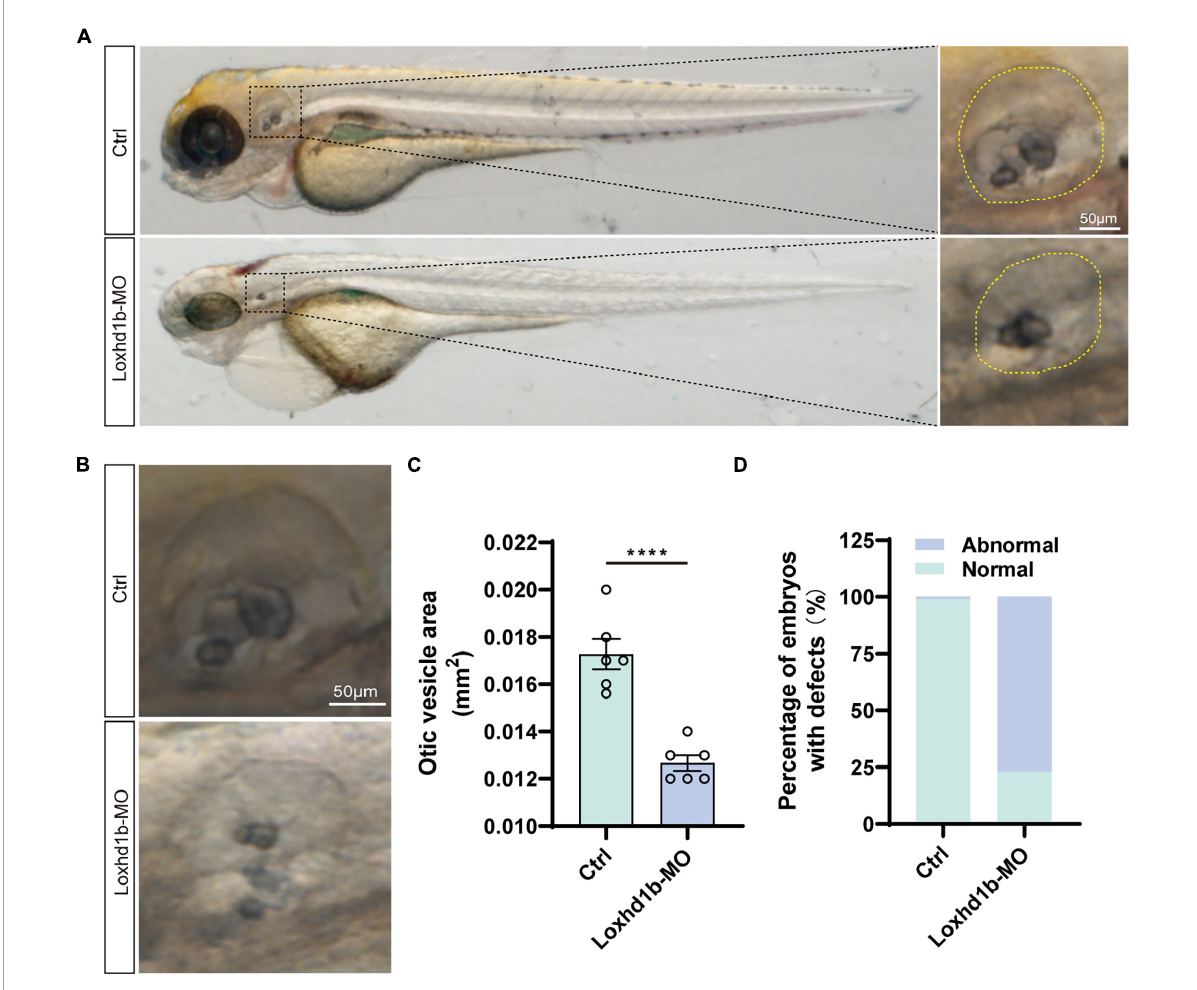
FIGURE5 Loss of function of Loxhd1b causes the defects of otic vesicle and otoliths. (A,B) Imaging analysis of otic vesicle in control and Loxhd1b knockdown at 72 hpf. The yellow dotted line marks the boundary of the otic vesicle. Scale bar = 50 µ m. (C) Statistical analysis of otic vesicle area in the control and Loxhd1b morphants at 72 hpf. (D) The Loxhd1b morphants with the utricle otolith lost, showing the decrease in number and defects in shape of otoliths, i.e., the Loxhd1b morphants showing either the utricle otolith lost or an abnormal saccular otolith. **** P <